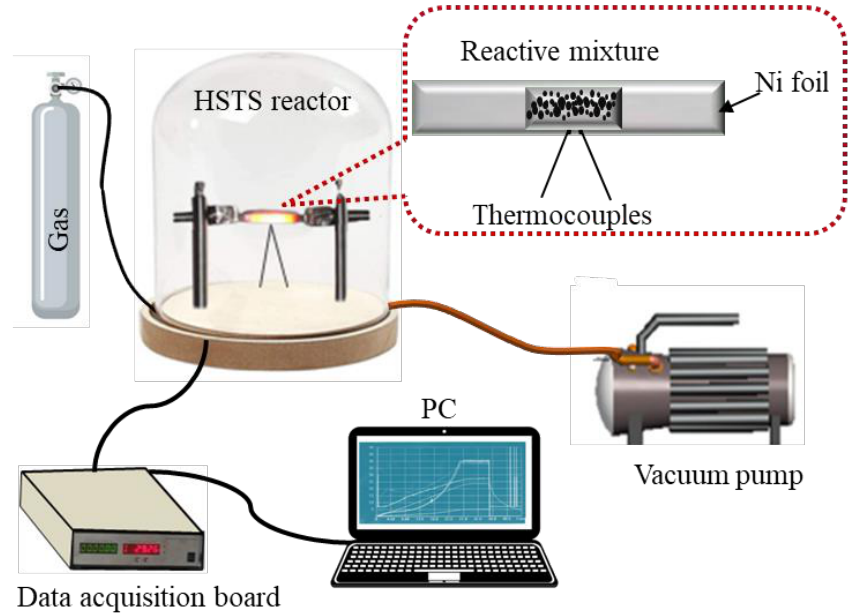
Figure 1. The scheme of HSTS technique.